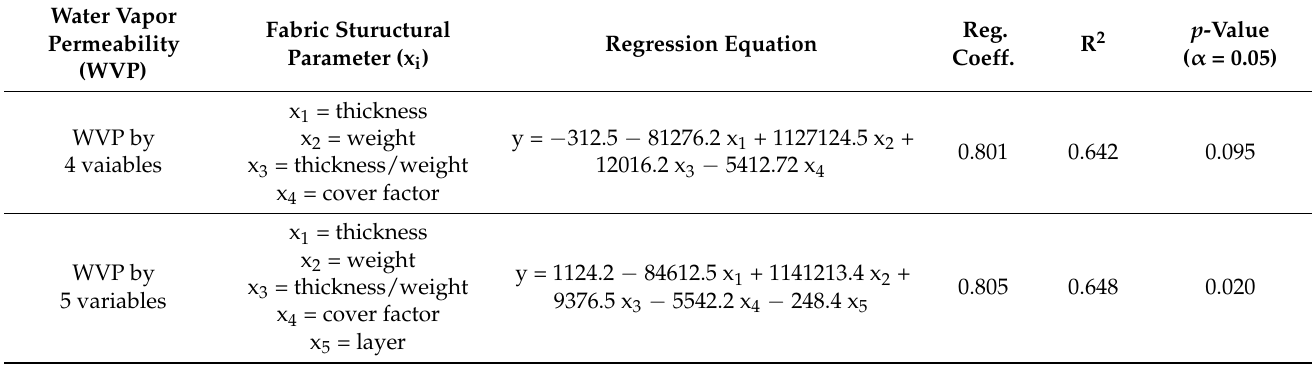
Table 4. Regression analysis between the MVP and fabric structural